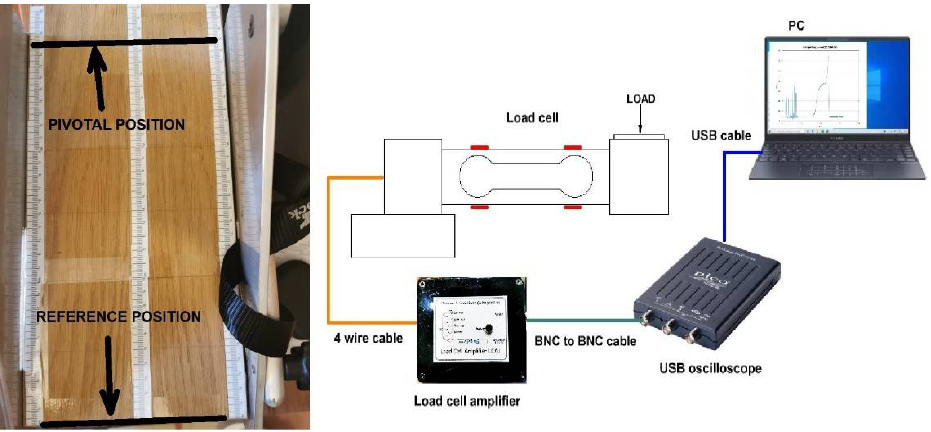
Figure 2. Pedal with distance ruler ( left ), block diagram of the measurement system ( right ).